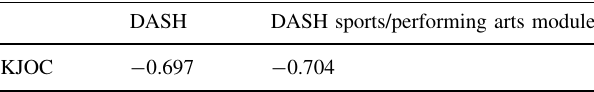
Table 2 Spearman correlation coefficient between the Kerlan–Jobe Orthopaedic Clinic Shoulder and Elbow score and the Disability of Arm, Shoulder, and Hand